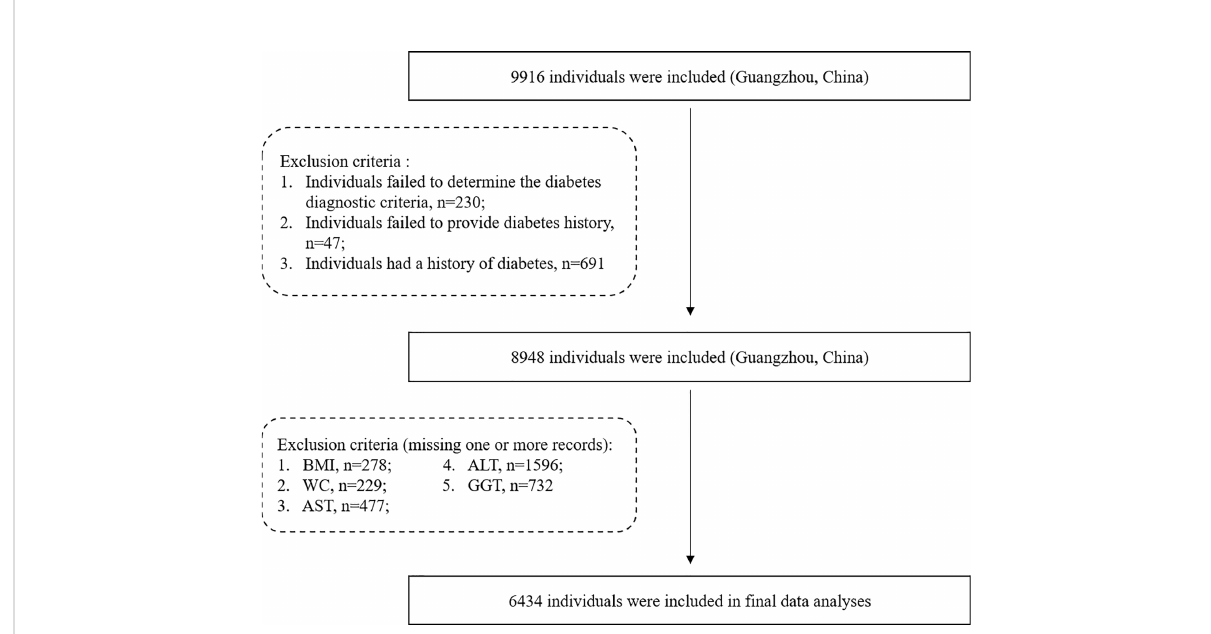
FIGURE 1 Study population fl